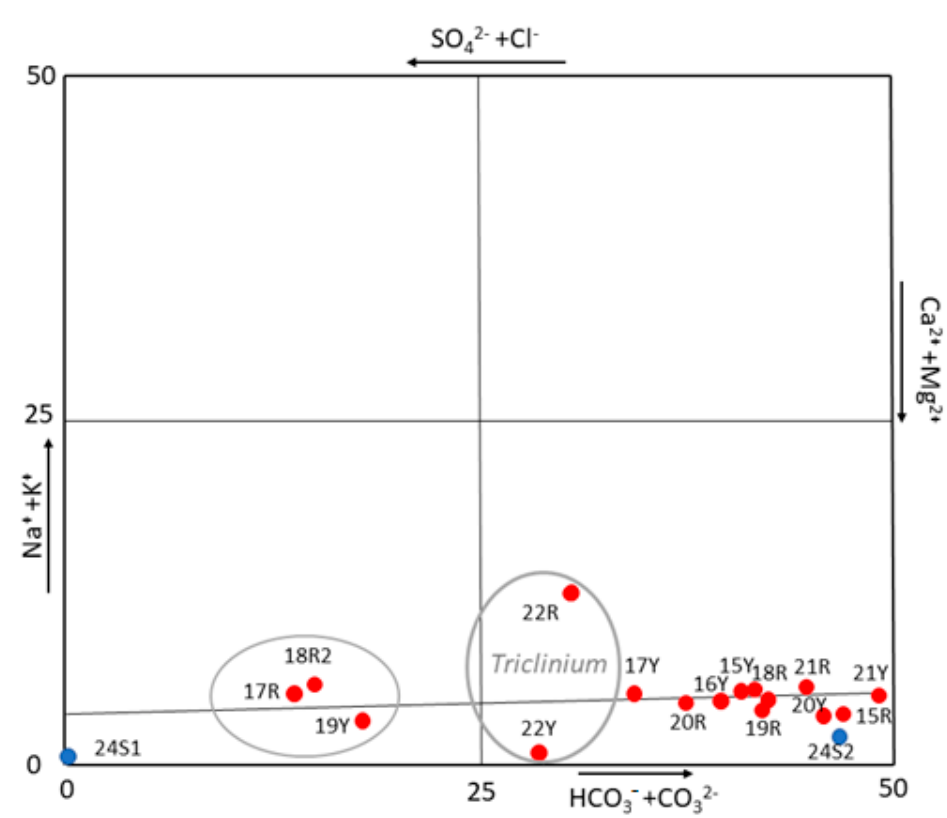
Figure 5. Anion and cations diagram (visualization and classification of hydro-chemical data) which excludes the marine water as origin of salts.